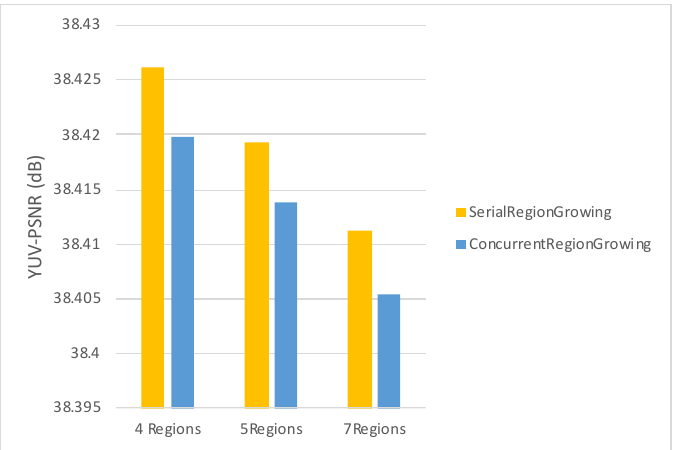
Figure 18. Average YUV-PSNR performance for 4, 5 and 7 regions (UVG